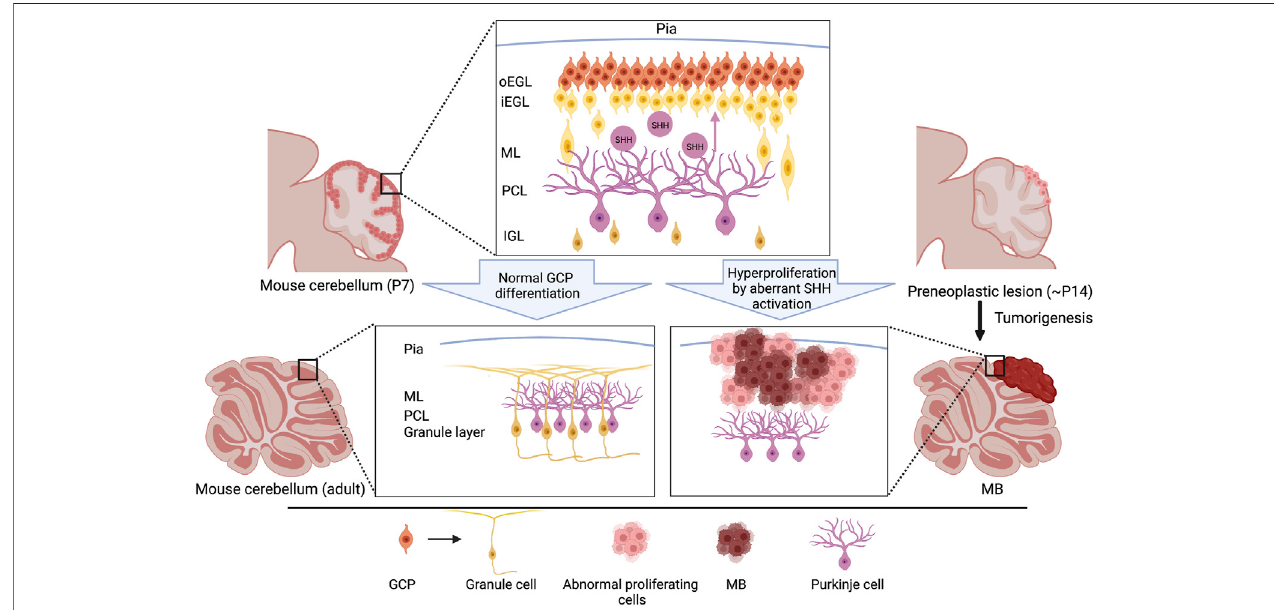
FIGURE2| SchematicrepresentationofcerebellardevelopmentandinitiationofMB SHH .Duringthepostnatalstage, GCPsnormallyproliferateintheouteredgeof the EGL under the regulation of SHH secreted by the Purkinje cells. GCPs exit the cell cycle and subsequently migrate radially, toward the IGL, to mature into the iEGL. SomaticgeneticmutationsoftencauseaberrantSHHsignalingthatresultsinafailuretoexitthecellcycle,leadingtohyperproliferation. Abnormal differentiationofGCPs inducestheformationofpreneoplasticlesionandMB SHH spredominantlyonthesurfaceofthecerebellarhemispheres(bottomright).Pleasenotethatthelocations ofother subtypes ofMBs, such asMB WNT sand MB Grp3/4 s,aredistinctfromthatofMB SHH s(Kawauchi et al.,2017),implying distinct cellular originsofthese subgroups. GCP, granule cell precursor; oEGL, outer external granular layer; iEGL, inner external granular layer; ML, molecular layer; PCL, purkinje cell layer. IGL, internal granular